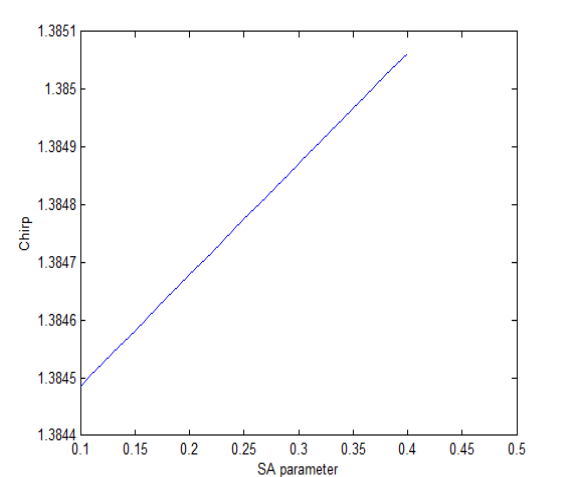
Fig.2: Chirp versus saturable absorption